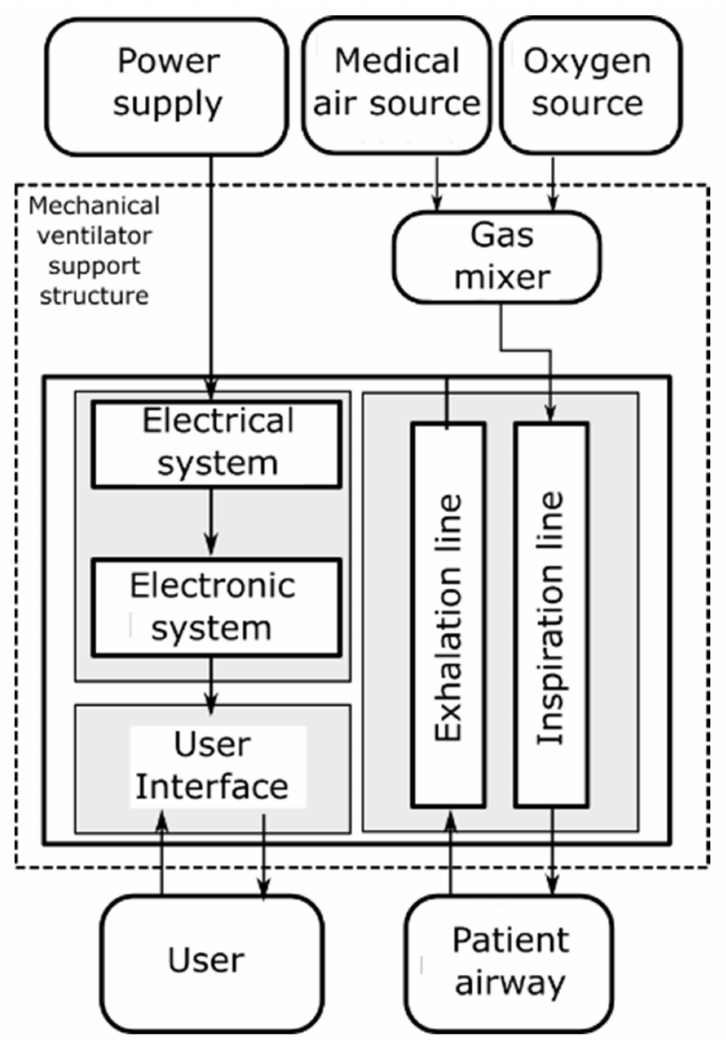
Figure 2. Block diagram with the fundamental components for the design of mechanical